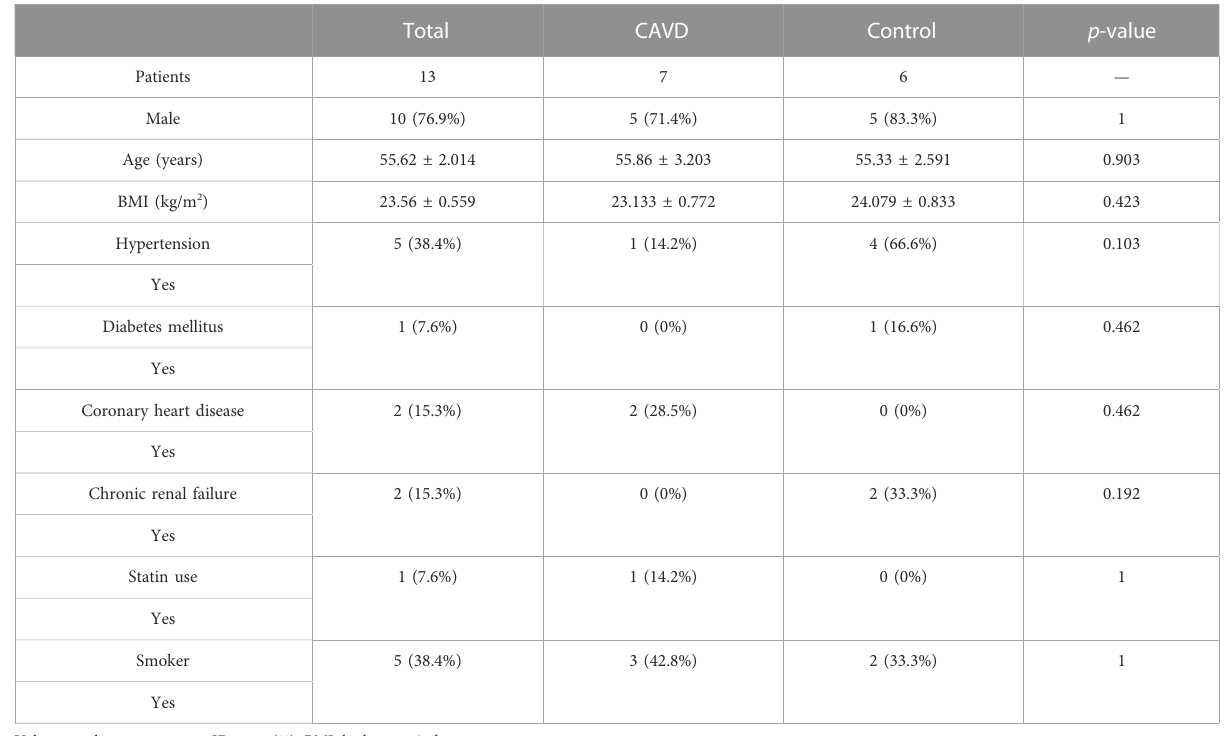
TABLE 2 Patient demographic